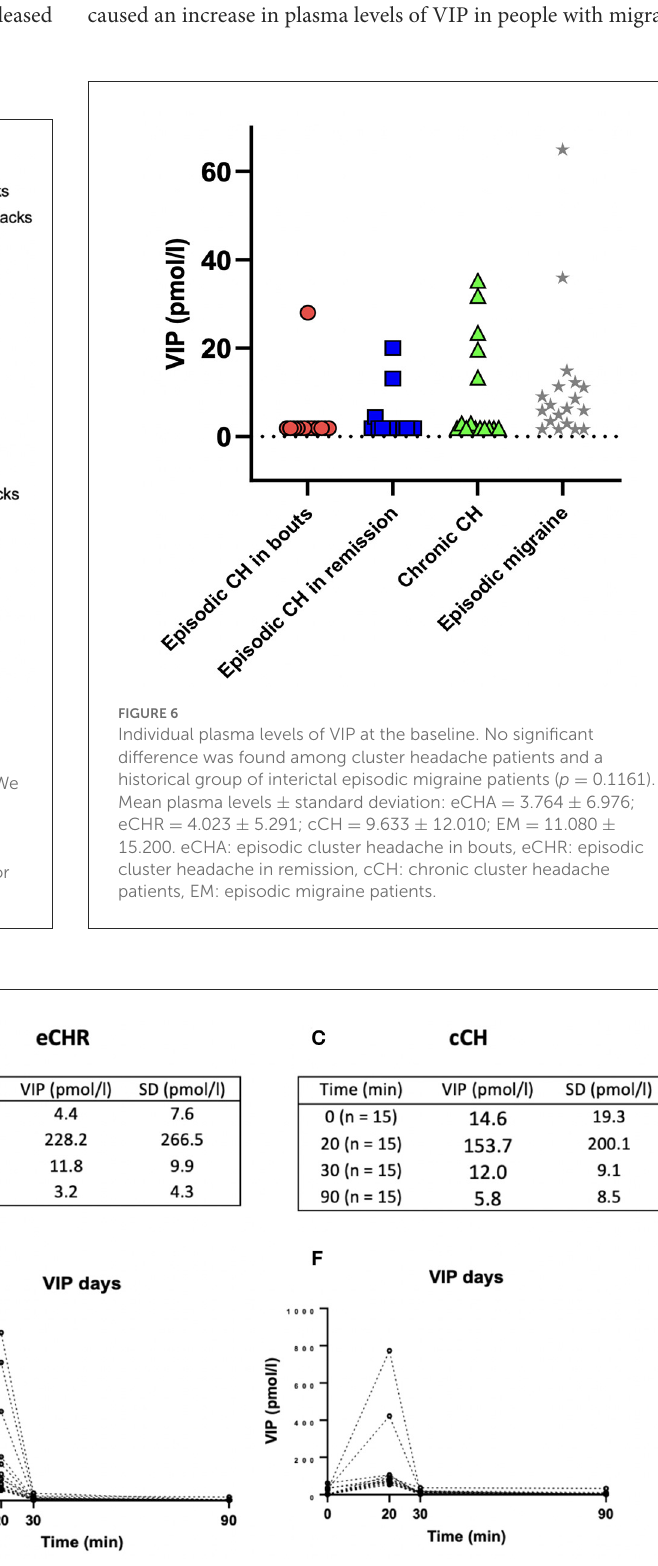
FIGURE5 Plasma levels of VIP (pmol/l) during VIP days. (A–C) Mean plasma levels of VIP among the three groups. (D–F) Individual values among the three